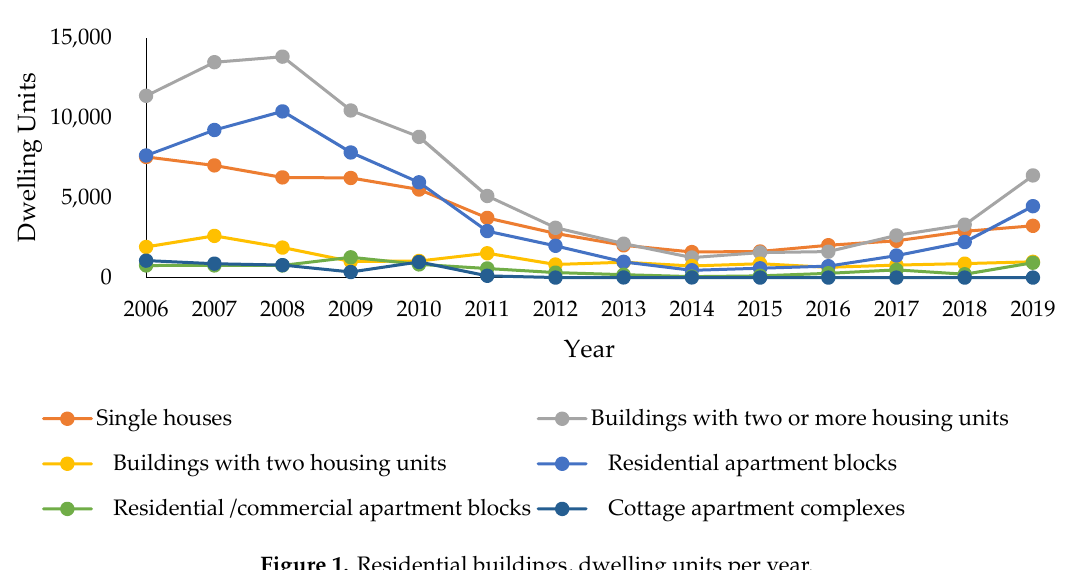
Figure 1. Residential buildings, dwelling units per year.